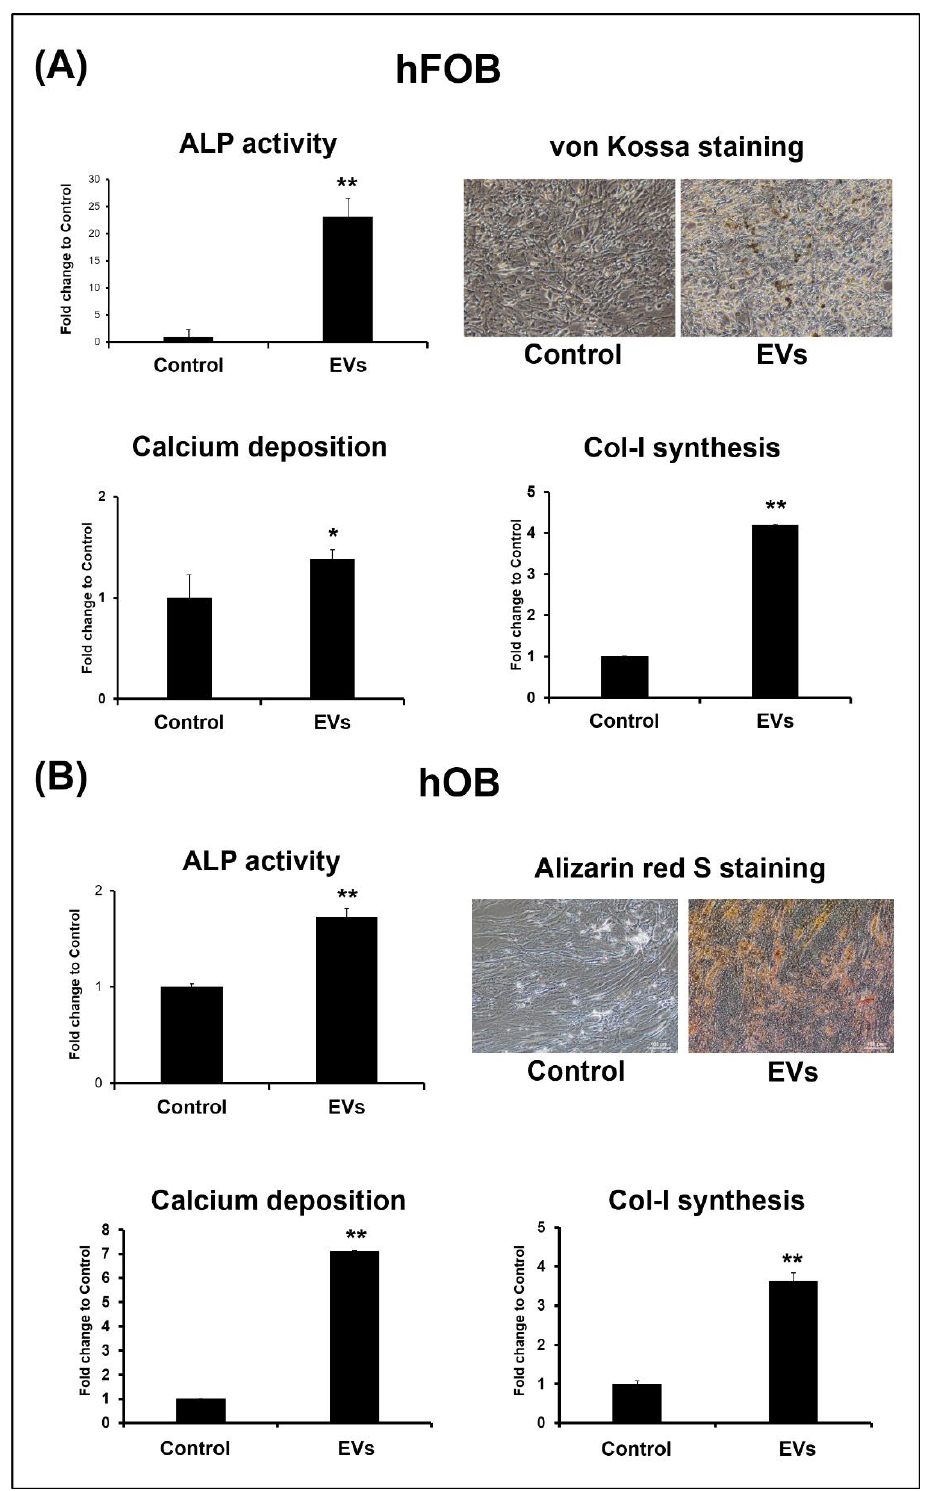
Figure 6. ADSC-EVs promote ALP activity, calcium deposition, and collagen type I ( Col-I ) synthesis in osteoblasts. The hFOBs ( A ) and hOBs ( B ) were treated with ADSC-EVs at concentrations of 0 (Control: control group) or 1 × 10 9 particles/mL (EVs: EV group) for 12 days and analyzed through von Kossa staining, Alizarin red S staining and quantification, and ELISA for ALP activity and Col-I synthesis. Data are presented as the mean ± SD ( n = 3). * p < 0.05 and ** p < 0.01 for comparisons with the control group.